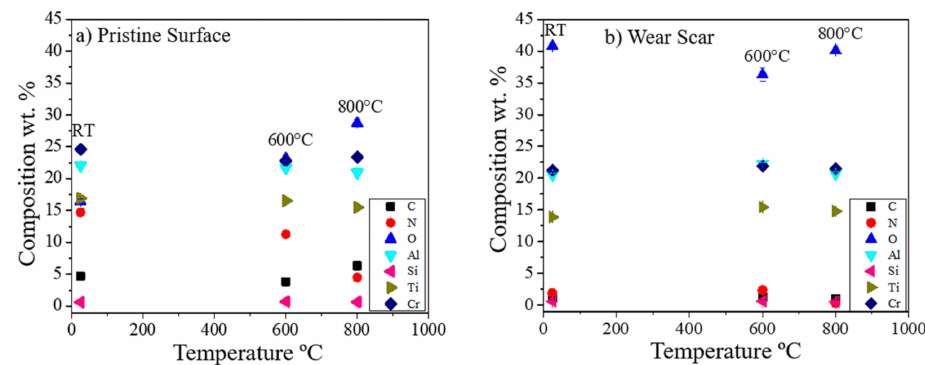
Figure 6. EDS data taken on ( a ) the coating pristine surface and ( b ) wear scars surface after the tests at di ff erent